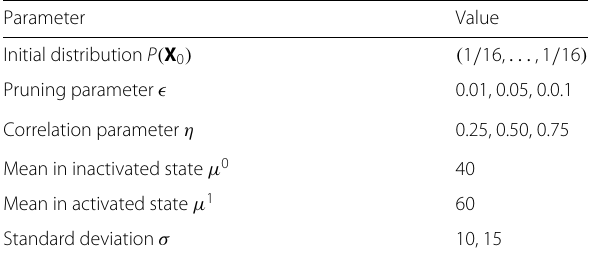
for i , j = 1, . . . , 2 d , where || x || 1 denotes the number of 1’s in the Boolean vector x